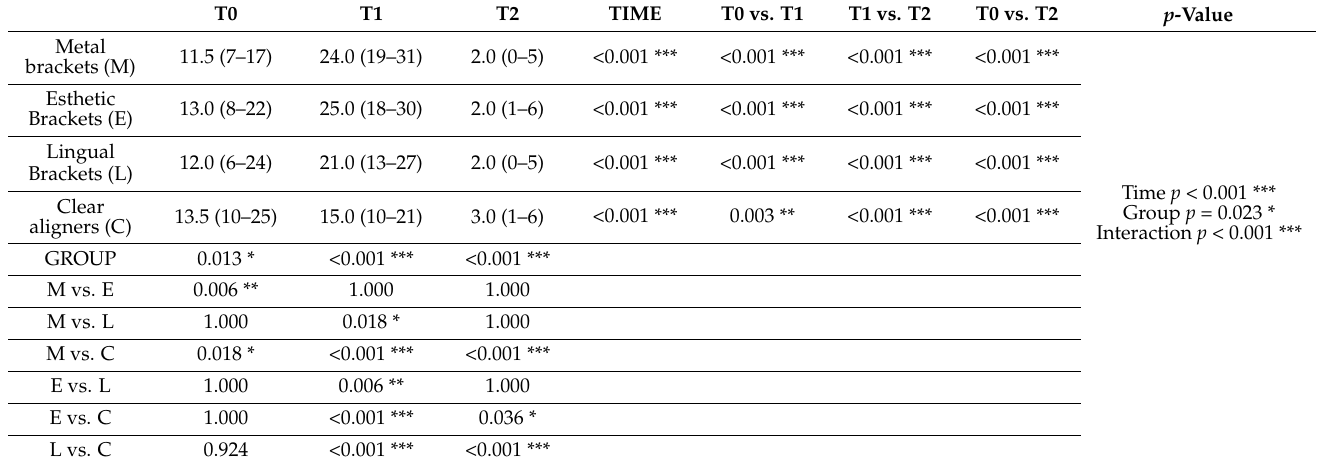
Table 2. Evolution of OHIP-14 total score of each group: median (range) and test ATS results with Brunner–Langer model, Kruskal–Wallis test and Mann–Whitney test with Bonferroni correction for comparisons between